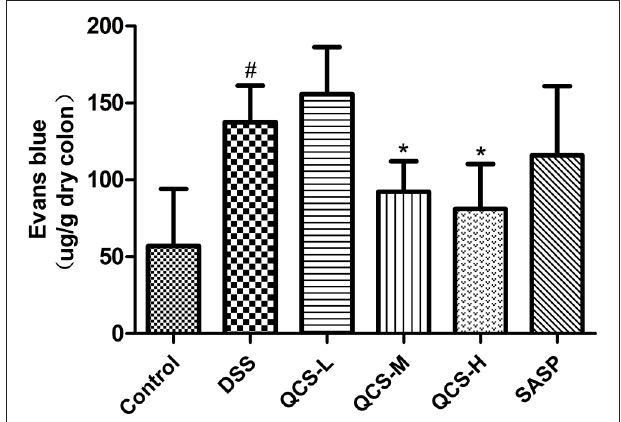
FIGURE 5 | Effects of QCS on VP in colon of rats with DSS-induced colitis. Quantitative measurement of VP. Data were expressed as mean ± SD ( n = 8), * P < 0.05, ** P < 0.01 vs. model group; ## P < 0.01, vs. control group.